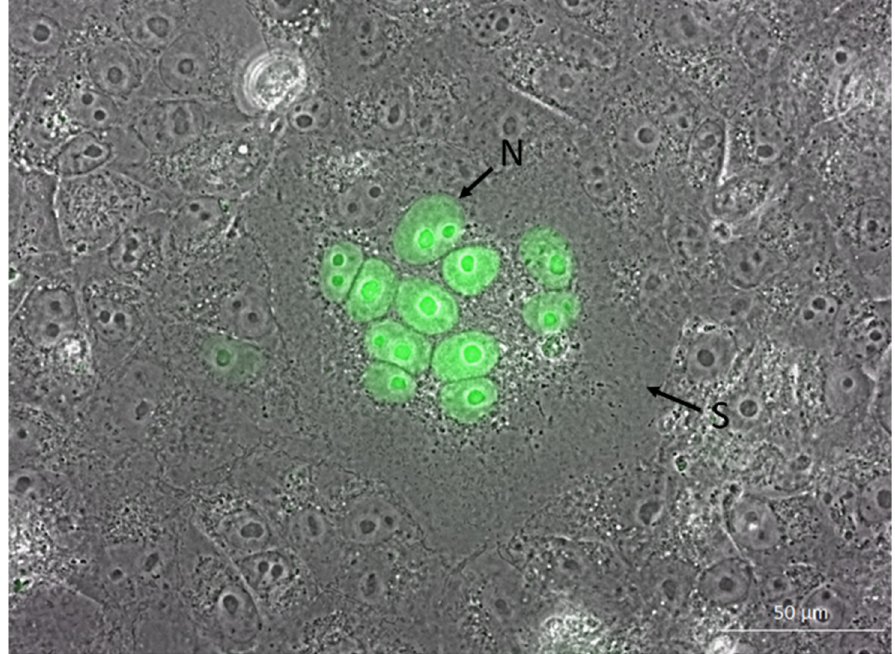
Figure 3. Induction of syncytia formation by the HSV-1 fusion machinery in Vero reporter cells. Transmission light microscopy of intact cells with phase contrast overlayed with EGFP-fluorescence, 63× oil. Green: EYFPNuc-positive nuclei. Arrows indicate syncytium (S) and nuclei (N).